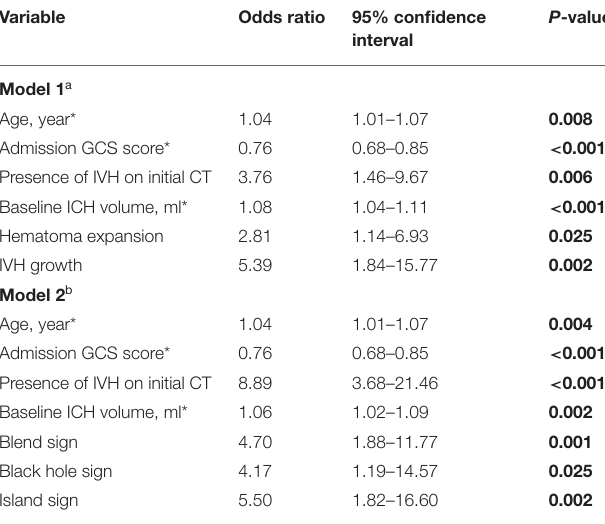
TABLE 2 | Multivariate analysis of predictors for poor outcome. Variable